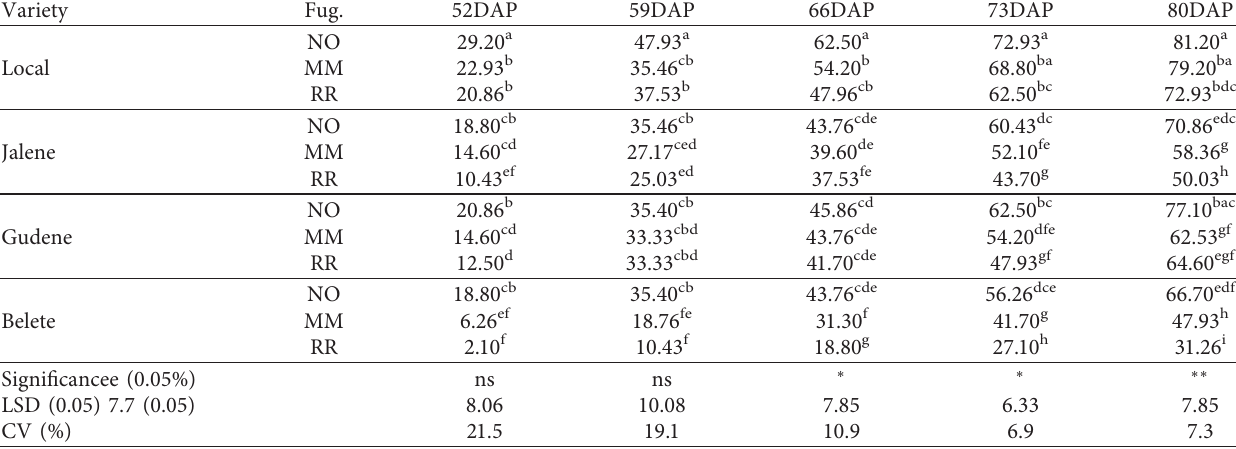
Table 1: Interaction effects of fungicides and potato varieties on late blight disease